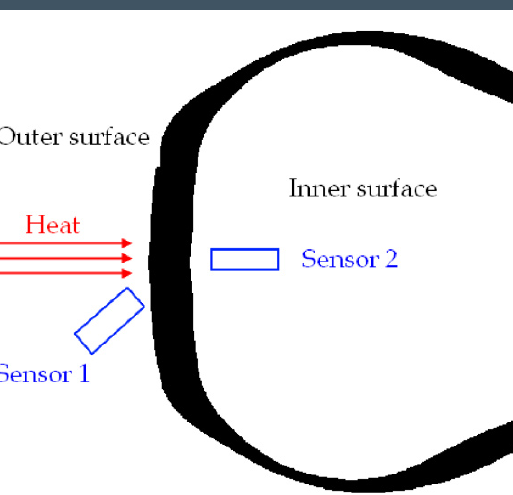
Figure 13. Diagram of the experimental test.